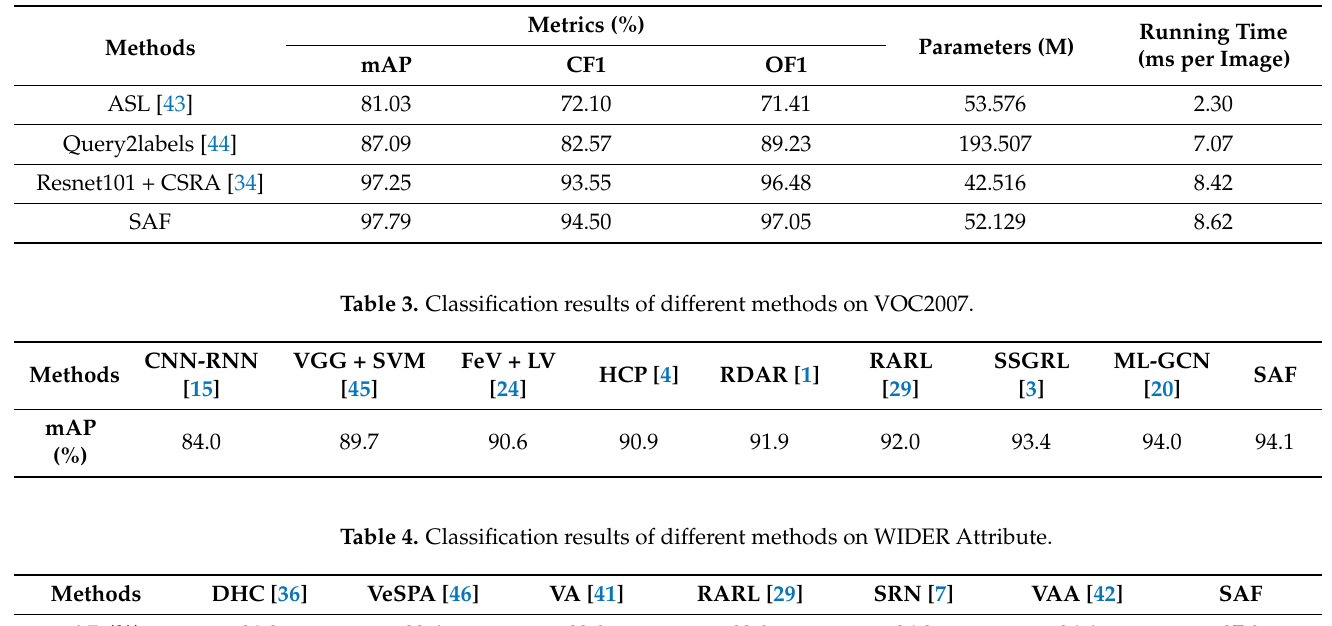
Table 2. Comparison results of two methods on metrics, parameters, FLOPs, and running time on waste bottle dataset.